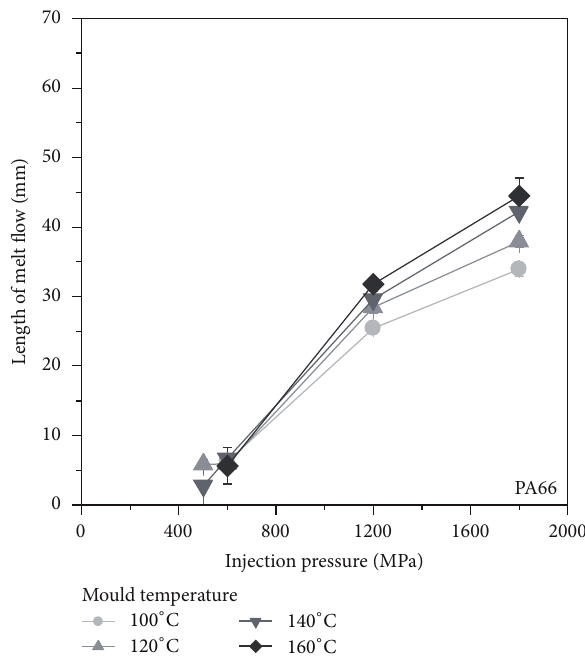
Figure 6: Flow length as function of injection pressure and mould temperature for PA66.